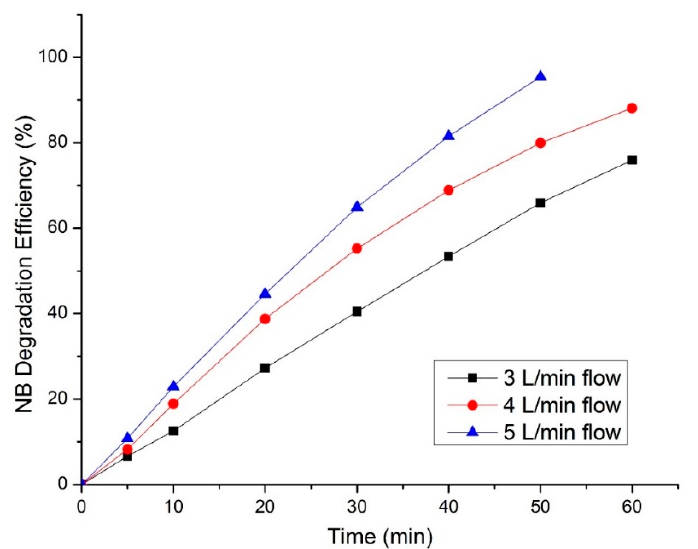
Figure 6. The e ff ect of di ff erent oxygen flow rates on the degradation of NB in the DBD reactor, at an NB concentration of 20 mg / L and an applied voltage of 1.8